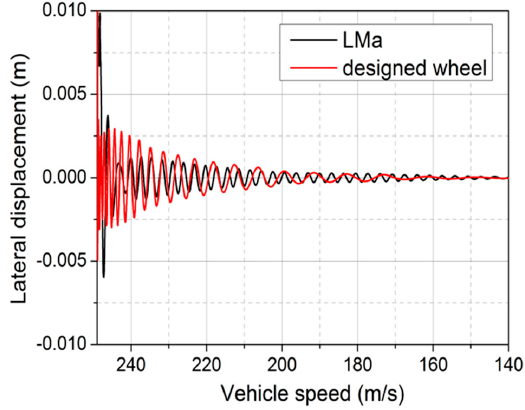
Figure 22. Critical speed.